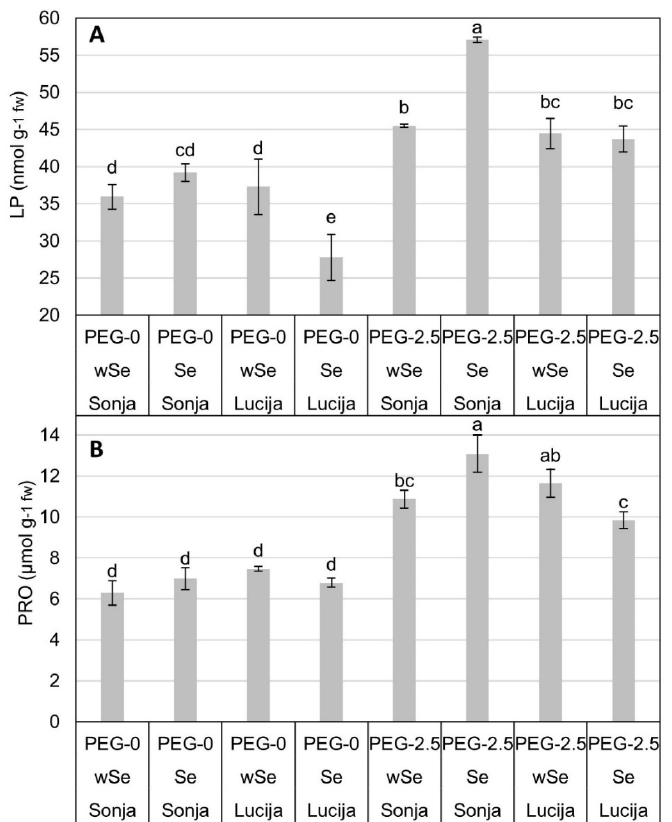
Figure 1. Means and standard errors (SE) of means for PRO (proline) ( A ) and LP (lipid peroxidation product) ( B ). Significance of effects is denoted with different letters at α = 0.05 level. There were no significant differences detected between groups in PEG-0 plants in TP content (Figure 2A). Plants treated with PEG-2.5 had a higher TP content by 27.17% than PEG-0 plants. The only significant difference in PEG-2.5, compared to other groups, was detected in Sonja with Se with a value of 1.049 mg GA g − 1 fw, while in the other groups, there were no significant differences. FRAP values (Figure 2B) in PEG-2.5 were higher by 45.29% compared to PEG-0 plants. Significant differences were detected between cultivar-